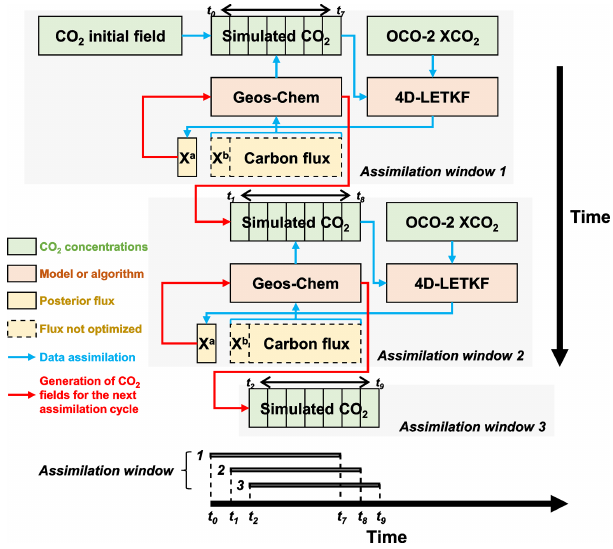
Figure 1. Modeling structure of the carbon flux inversion system developed in this